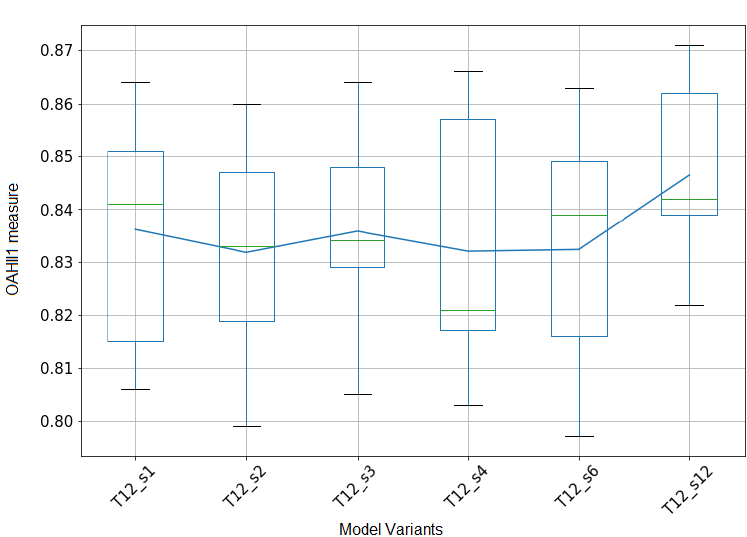
Figure 9. Boxplot of OAHII1 measures of framework variants. Blue line represents mean scores.